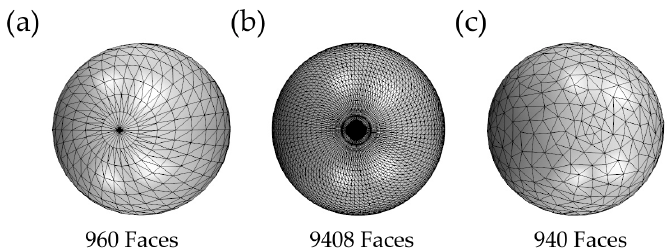
Figure 1. Di ff erent surface triangulations of a sphere: ( a ) Blender, ( b ) STAR-CCM + , ( c ) using Blender Figure 1. Different surface triangulations of a sphere: ( a ) Blender, ( b ) STAR-CCM+, ( c ) using Blender option Decimate Geometry on (b). option Decimate Geometry on ( b